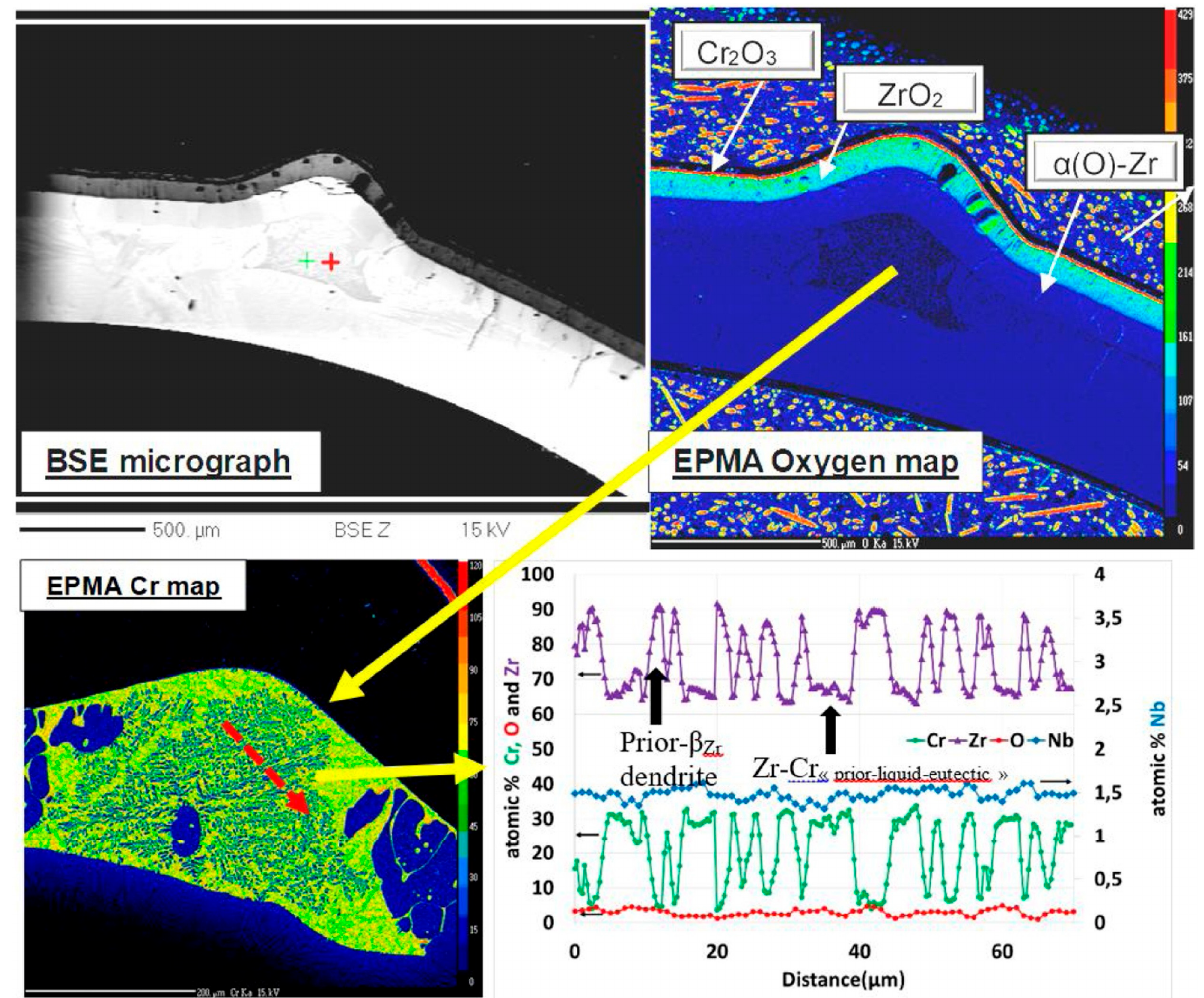
Figure 14. Microstructure of 12–15 µm thick Cr-coated M5 Framatome cladding segment after steam oxidation at 1400 °C for 100 s, followed by water quenching. Reproduced from [166] with permission by Elsevier.